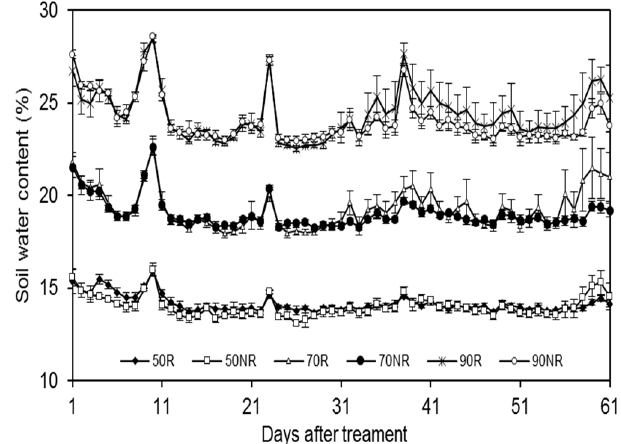
Figure 1. Changes of daily average soil water contents in the pots under the soil water levels at 90%, 70%, and 50% of soil water holding capacity (SWHC) and rhizobia inoculation (with rhizobia (R) and without rhizobia (NR)). Values are means ± standard error (SE) (n = 4).